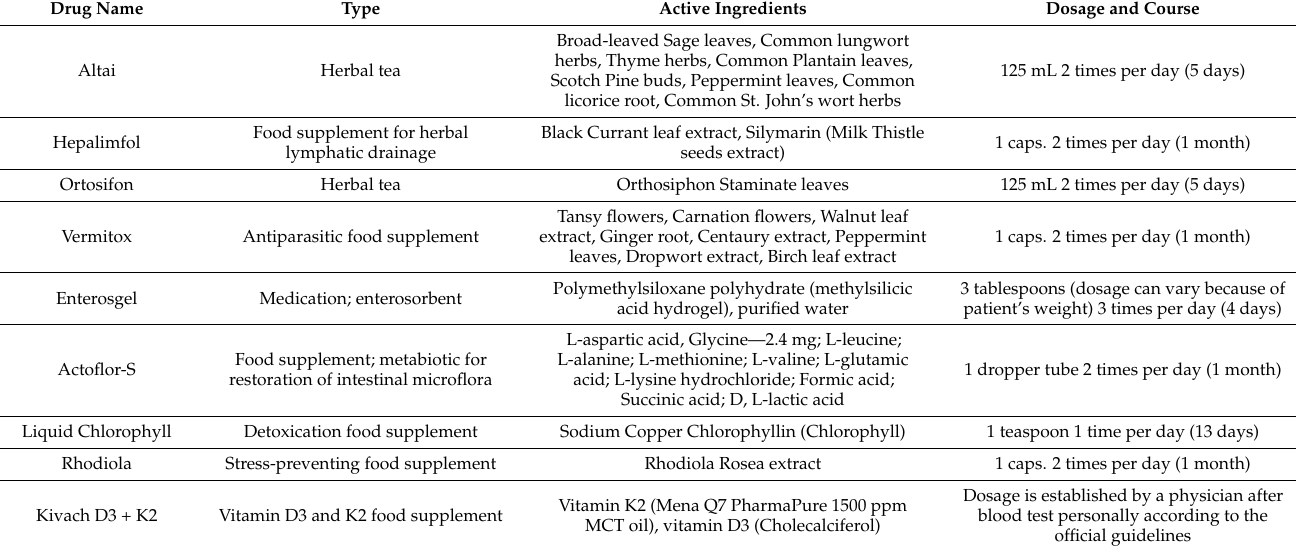
Table 1. Drug Therapy Prescribed in this